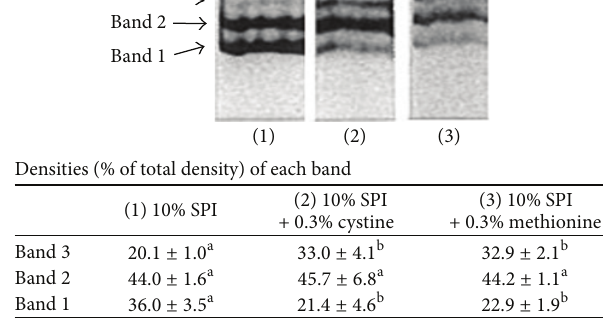
Figure 4: Effect of BSO on glutathione concentration and G6PD activity of isolated cultured hepatocytes. Isolated rat hepatocytes were incubated for 48 h in WE medium containing 10 −6 M dex- amethasone, 0.1 𝜇 g/mL aprotinin, 30 𝜇 g/mL kanamycin, and 10 −7 M insulin in the presence of 0–0.5 mM BSO. Glutathione level (closed circle)andG6PDactivity(opencircle)weredeterminedateachBSO concentration.